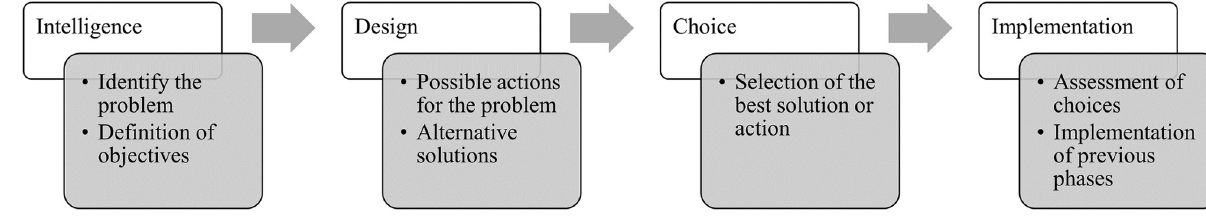
Fig 1. Iterative phases of the decision-making